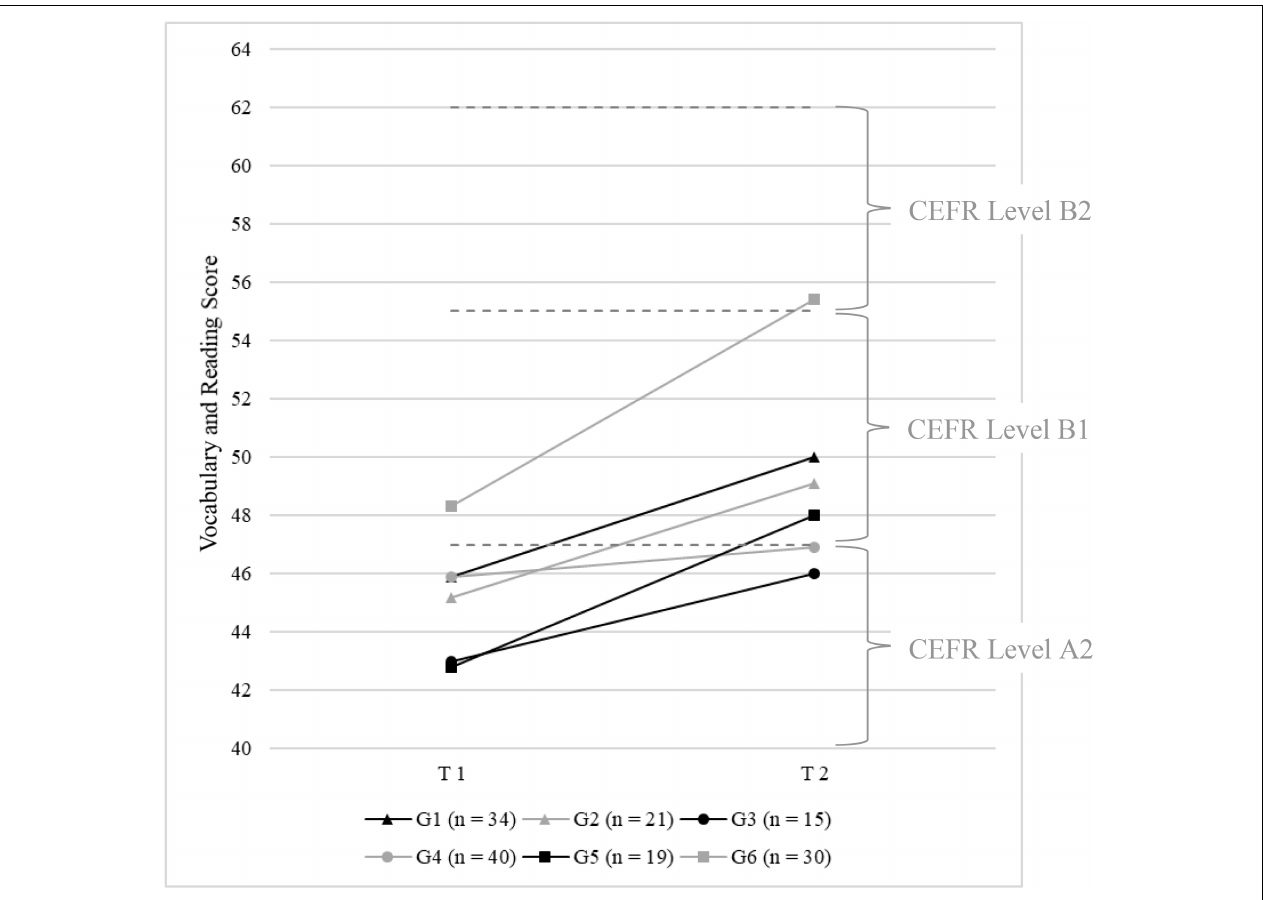
FIGURE 5 | Development of the English skills in the competence area “Vocabulary and Reading” (from 31 = worst result to 67 = best result). T, Time of Measurement; G1, student-athletes with Additives Abitur at Elite Sport School 1; G2, student-athletes without Additives Abitur at Elite Sport School 1; G3, student-athletes without Additives Abitur at Elite Sport School 2/3; G4, dropouts at Elite Sport School 1; G5, dropouts at Elite Sport School 2/3; G6, non-student-athletes at comprehensive schools; CEFR, Common European Framework of References for